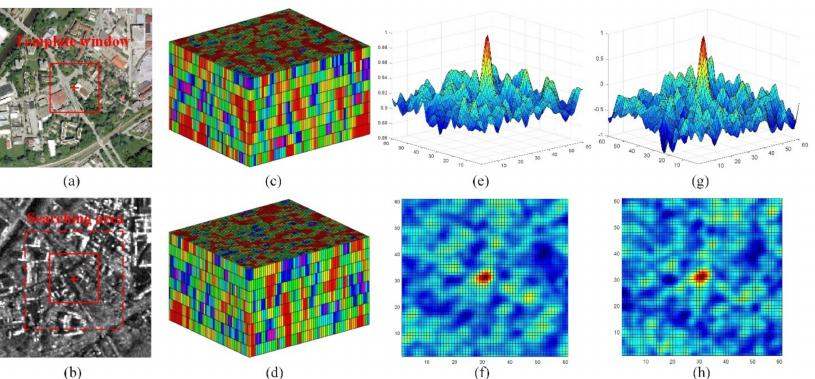
Figure 6. Comparative matching experiments of PC and NCC on an image pair of an optical satellite image and SAR images. ( a ) Optical satellite image with a template window of 61 × 61 pixels. ( b ) SAR image with a searching area of 121 × 121 pixels. ( c , d ) are the AWOG descriptors generated from the optical satellite image and SAR image, respectively. ( e , g ) are the 3D visualization of similarity values for PC and NCC with AWOG descriptors, respectively. ( f , h ) are the corresponding 2D similarity maps of ( e , g